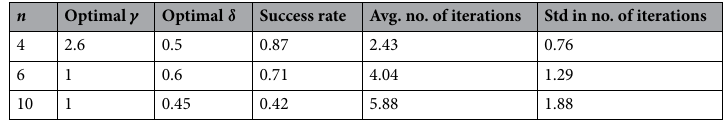
Table 2. Optimal parameters and statistical information from 1000 simulations.